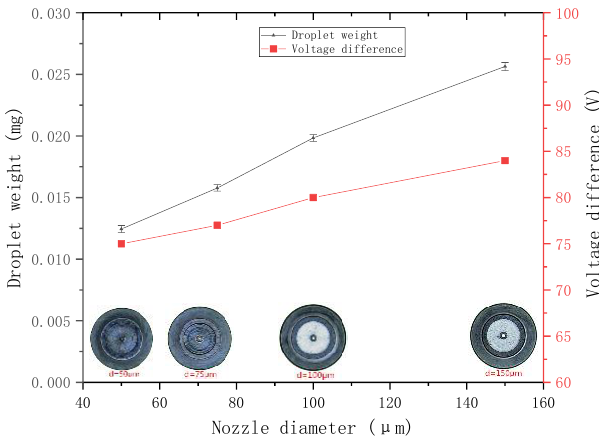
Figure 16. Relationship between the droplet weight, the minimum voltage difference, and the nozzle diameter.